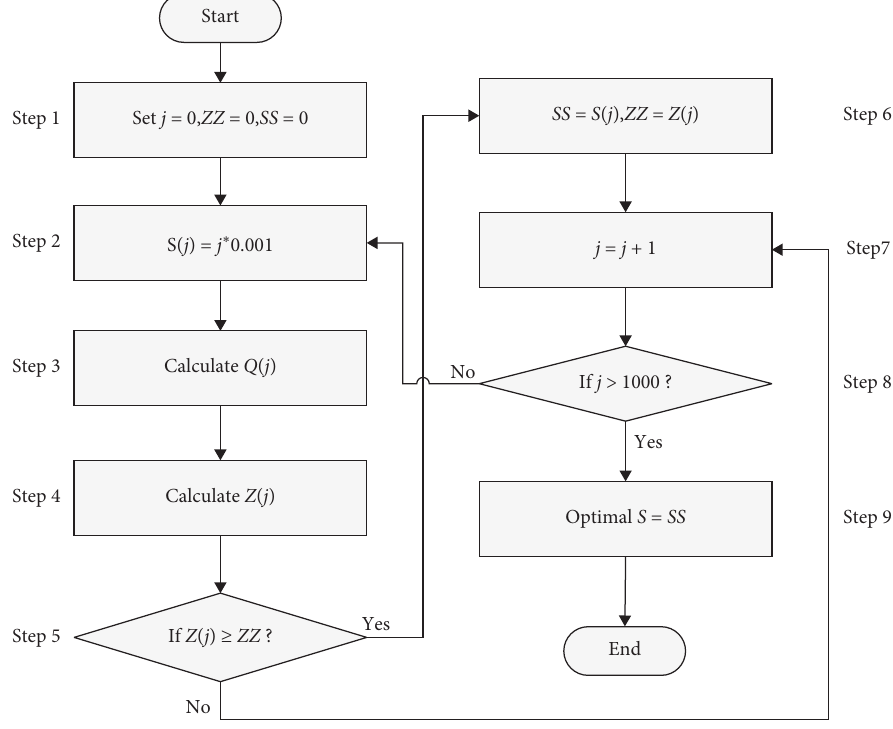
Figure 1: Simulation optimization process. Table 3: Simulation computation results of the